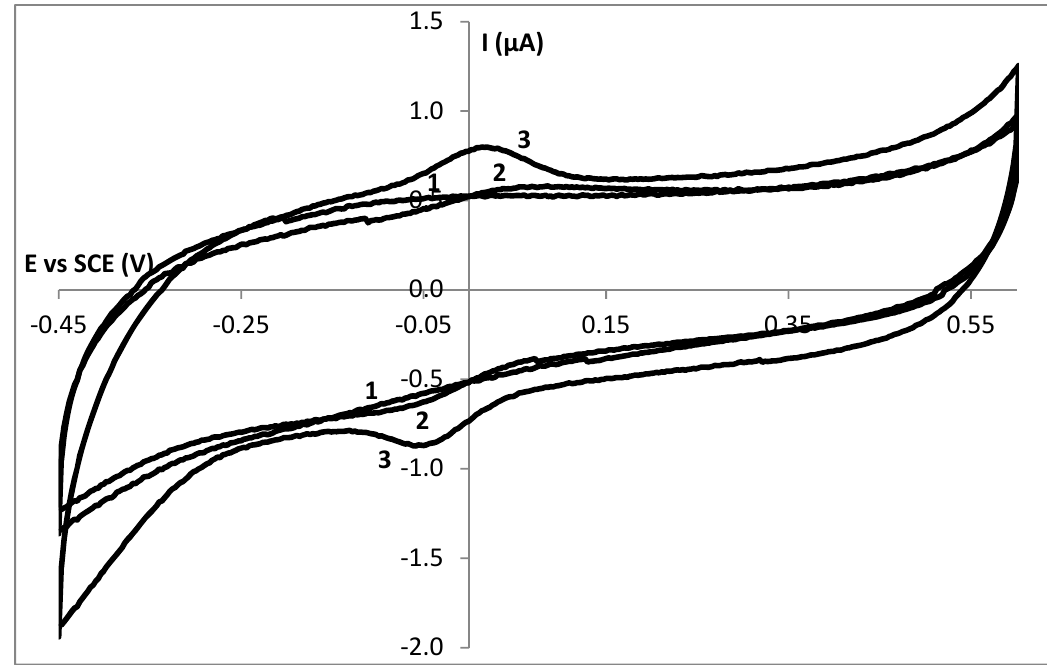
Figure 1. The current potential behaviour of a GelB|C (1), a drop dried HHC|GelB|C (2) and a spin coated HHC|GelB|C (3) electrode in a 10 mmol·L − 1 HEPES pH 7 buffer solution with a scan rate of 50 mV·s − 1